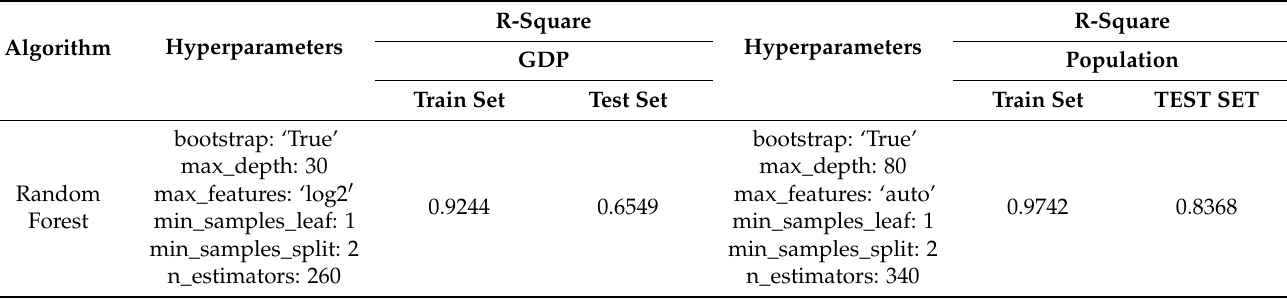
Table 5. Hyperparameters and prediction accuracy of random forest model.